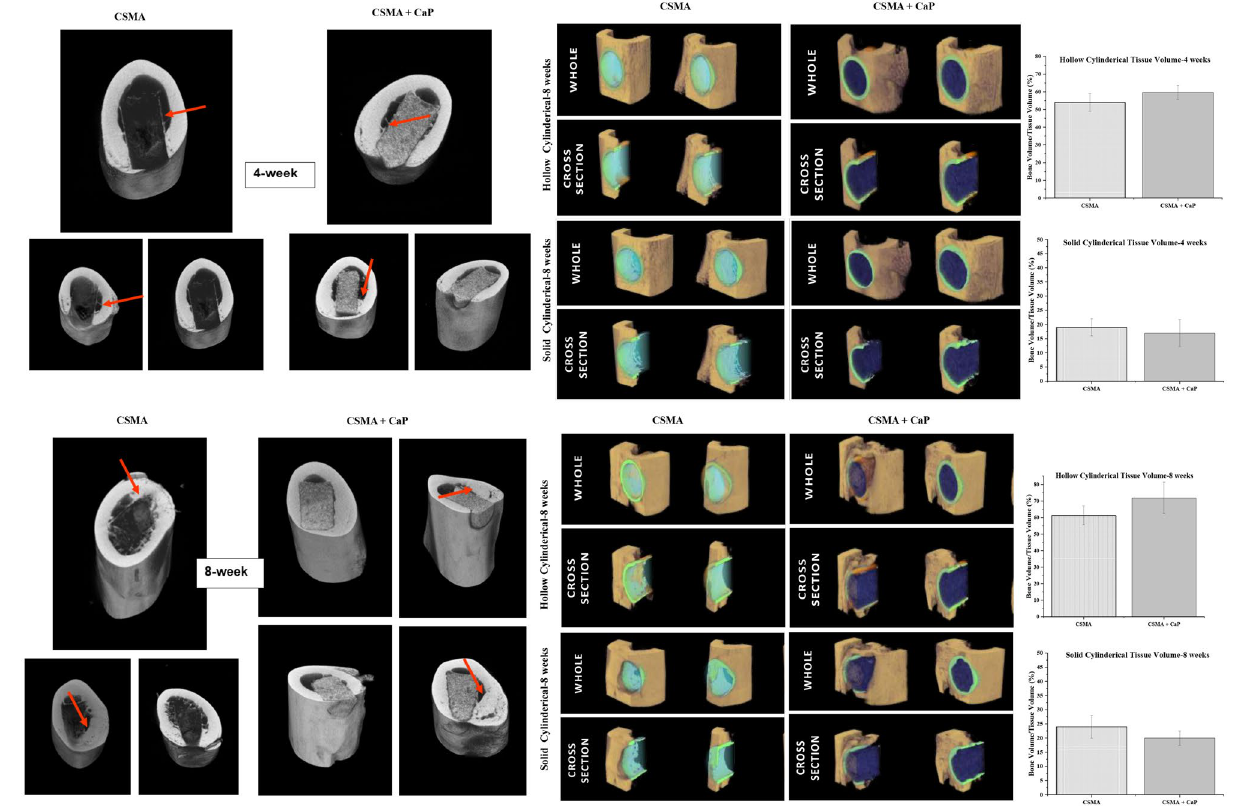
Figure 10. Representative implantation of CSMA polymer and CSMA + CaP composite in the femur of a rat’s model 4 and 8 weeks post-surgical insertion. At week 4, the integration of CSMA based implants with the native bone can be detected. This is particularly obvious where the red arrows are pointing; due to the nature of the CaP filled composite, there is a clearer bone ingrowth in CSMA + CaP. At week 8, an indication of new